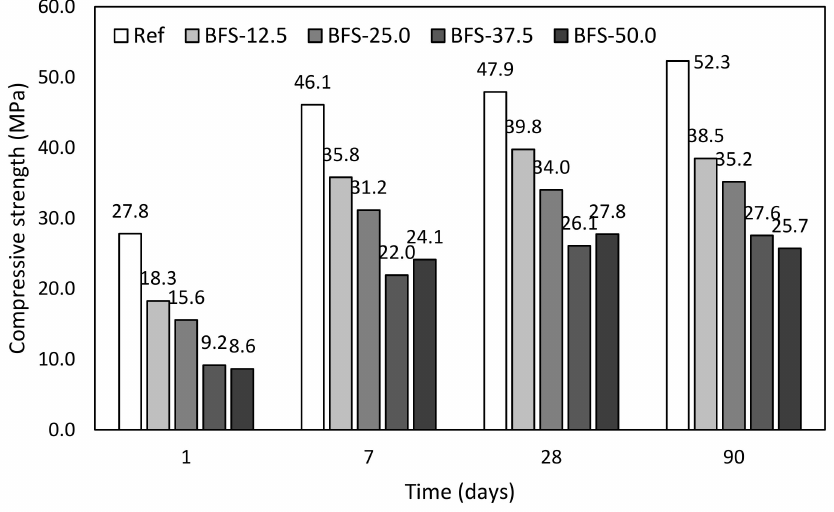
Figure 8. Evolution of compressive strength of mortars with blast furnace